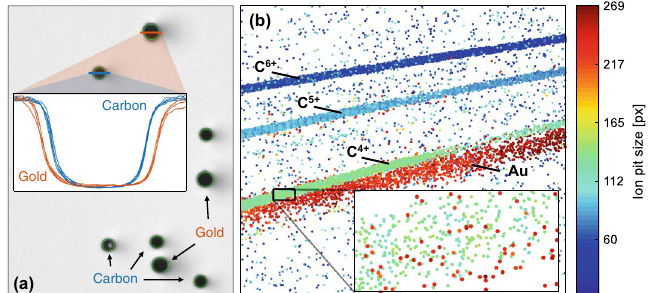
Figure 2. ( a ) Microscope image of an irradiated CR-39 sheet. The black dots originate from gold and carbon impacts and have been registered by the software SAMAICA, which fitted ellipses around the dots (in green). Carbon and gold ion impacts can be discriminated by their size, which is confirmed by the inset showing lineouts through several pits of the respective ion species. The FWHM of the carbon and gold ion impacts in this specific example are about 32 and 38 pixels, respectively (not shown in the figure). ( b ) Scanned CR-39 image from a detector placed behind the TPS. Each point corresponds to an ion impact. The color map visualizes the ion pit size in form of the enclosed area (number of enclosed pixels). The visible structures can be assigned to 6 + 5 + 4 + C , C , C and gold ions, respectively. This image shows the dependency of the ion pit size both on ion species (carbon ions in green and gold ions in red can be distinguished even in their overlapping region, see inset) and on the particles’ kinetic energies.